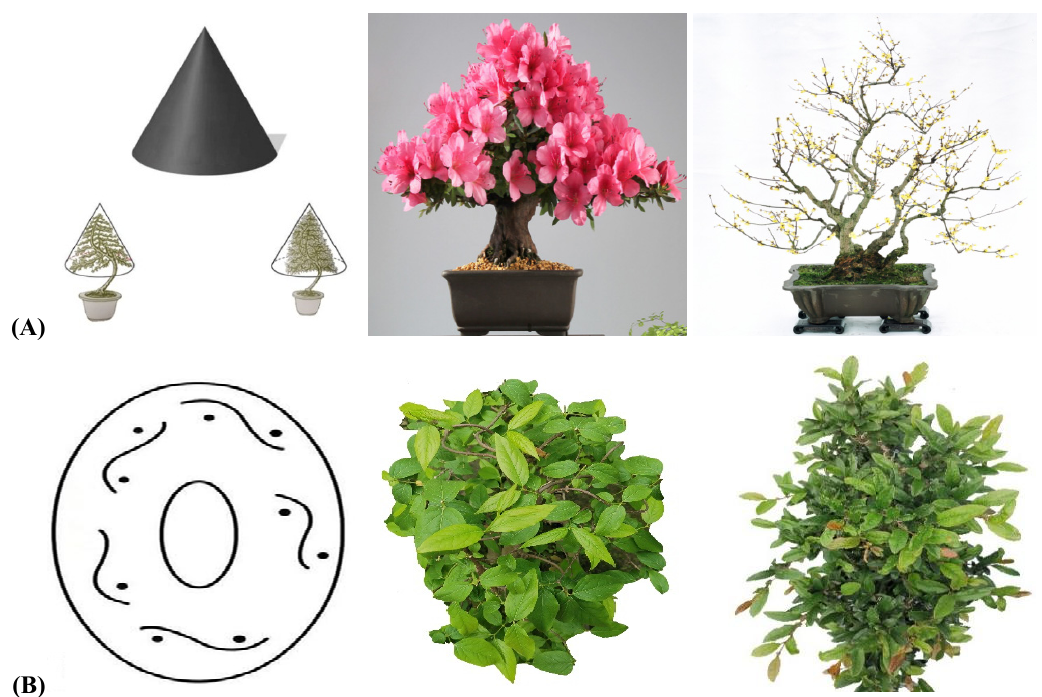
Figure 8. The horizontal ( A ) and frontal ( B ) views of the large/small rolling-branch